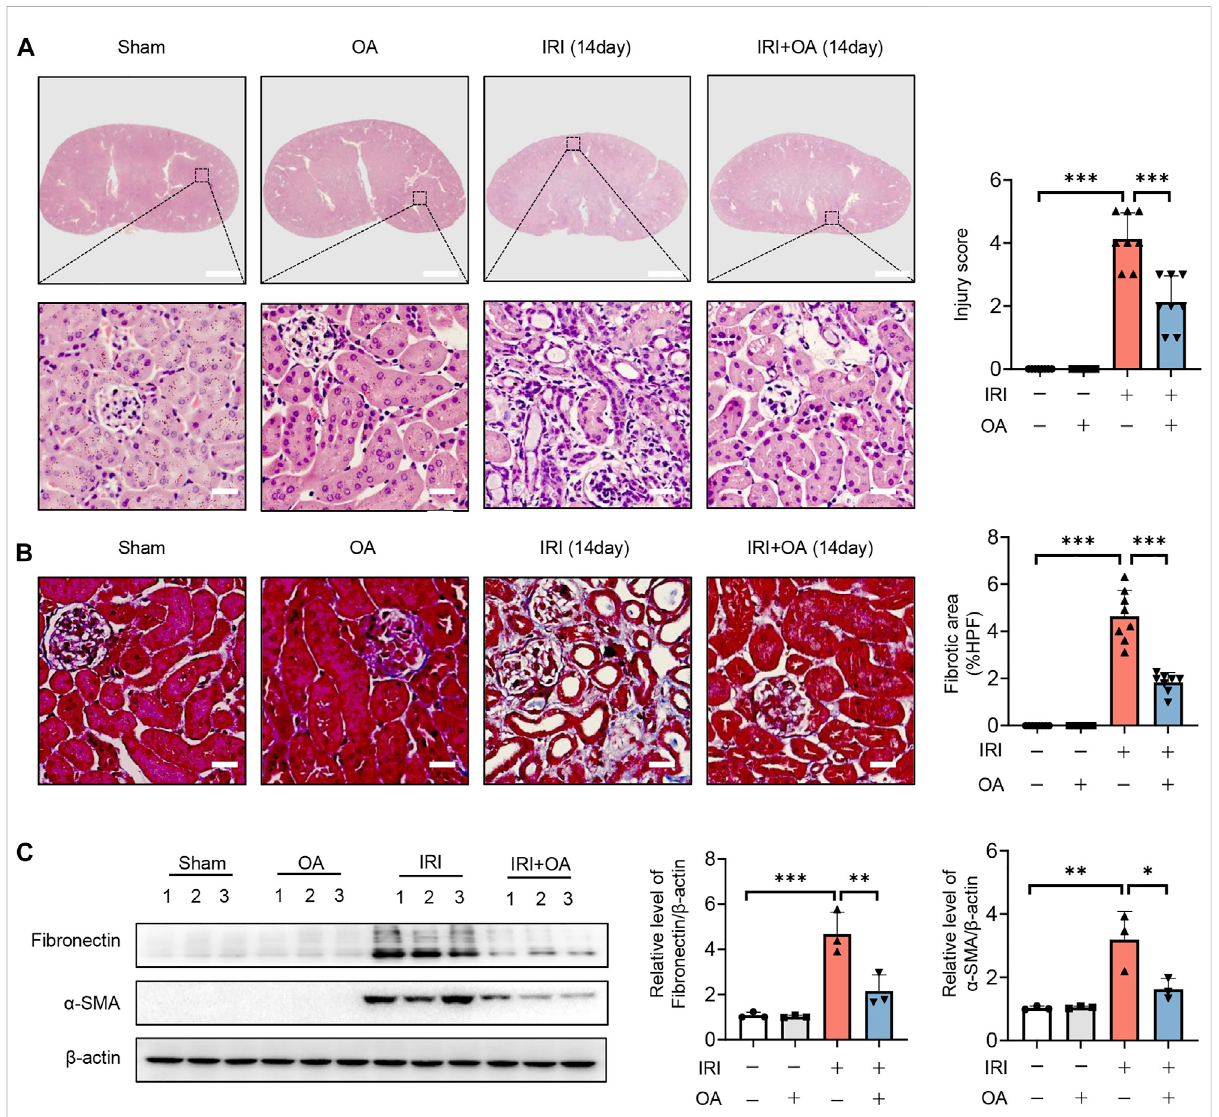
FIGURE 8 OA attenuates the transition of AKI-to-CKD. A 35-min bilateral IRI-induced AKI-to-CKD mouse model was constructed, which was intravenously injected with control or OA (20 mg/kg). Mice were euthanized 2 weeks later. (A) Representative images of HE staining. Scale bars, 1.25 mm (top) and 50 μ m (bottom). (B) Representative images of Masson staining. Scale bar, 50 μ m. (C) Western blot analysis of the expressions of fi brosis markers (Fibronectin and α -SMA) in the kidney tissues ( n = 3). Data are expressed as means ± SEM. p P < 0.05, pp P < 0.01, ppp P <